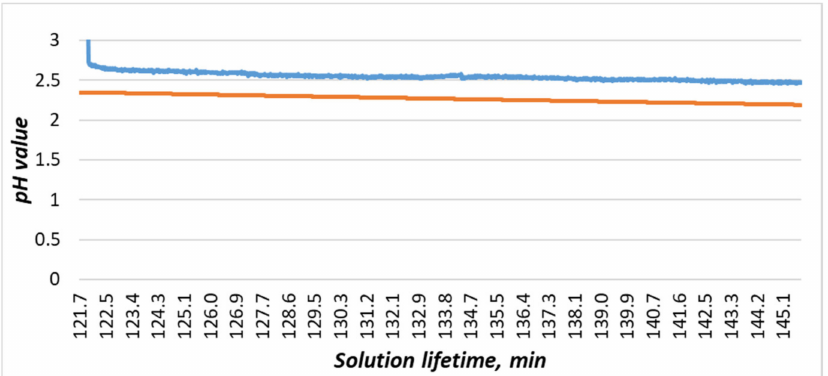
Figure 21. Comparison of the experimental data obtained from the acidity sensor (blue curve) with the mathematical dependence (2) (orange